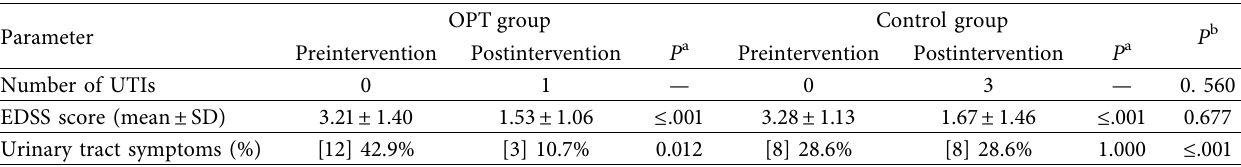
Table 2: Pre- and postintervention values for the number of UTIs, EDSS score, and urinary tract symptoms in the two study